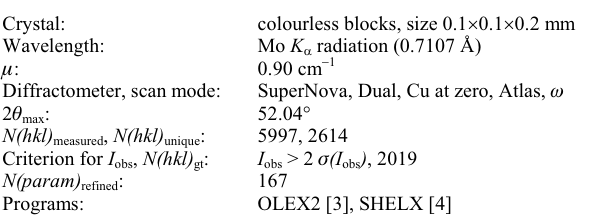
Table 1. Data collection and handling.